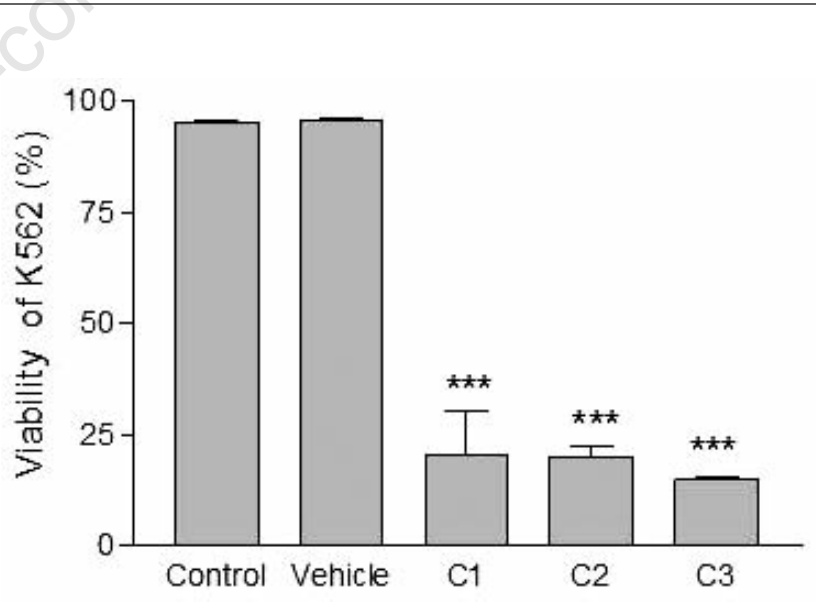
Figure 5. Effects of the higher concentration of PCDD/Fs mixture (C3) on the E. andrei NK-like cell activity to lyse the human tumor cells (K562). The effectors were fixed before contact with K562.